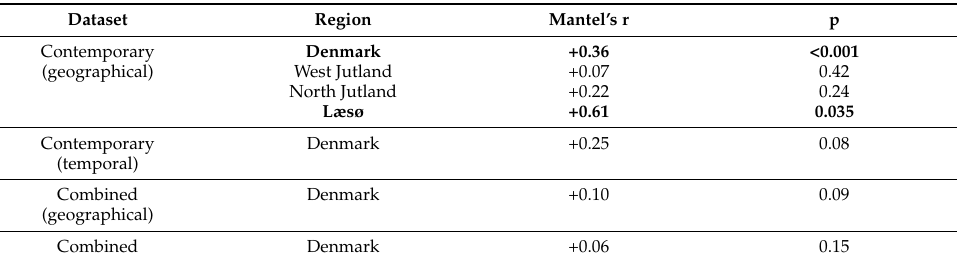
Figure 11. Plots showing isolation by distance ( A ) and year ( B ) for the combined dataset. Table 4. Summary of Mantel tests of isolation by distance and isolation by time for the different datasets. The highly significant results for isolation by distance for the contemporary dataset are also broken down by region. Statistically significant associations are shown in bold.